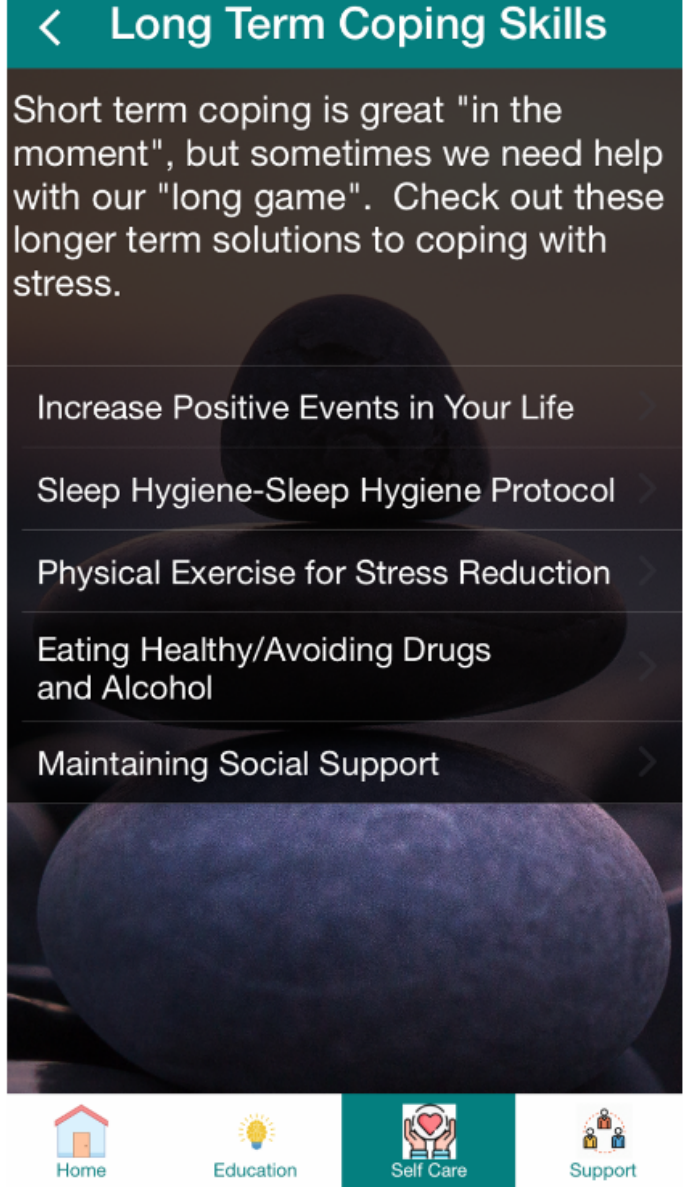
Figure 3. Sample Food Allergy Symptom Self-Management with Technology for Caregivers (FASST) mobile health (mHealth) smartphone app screen